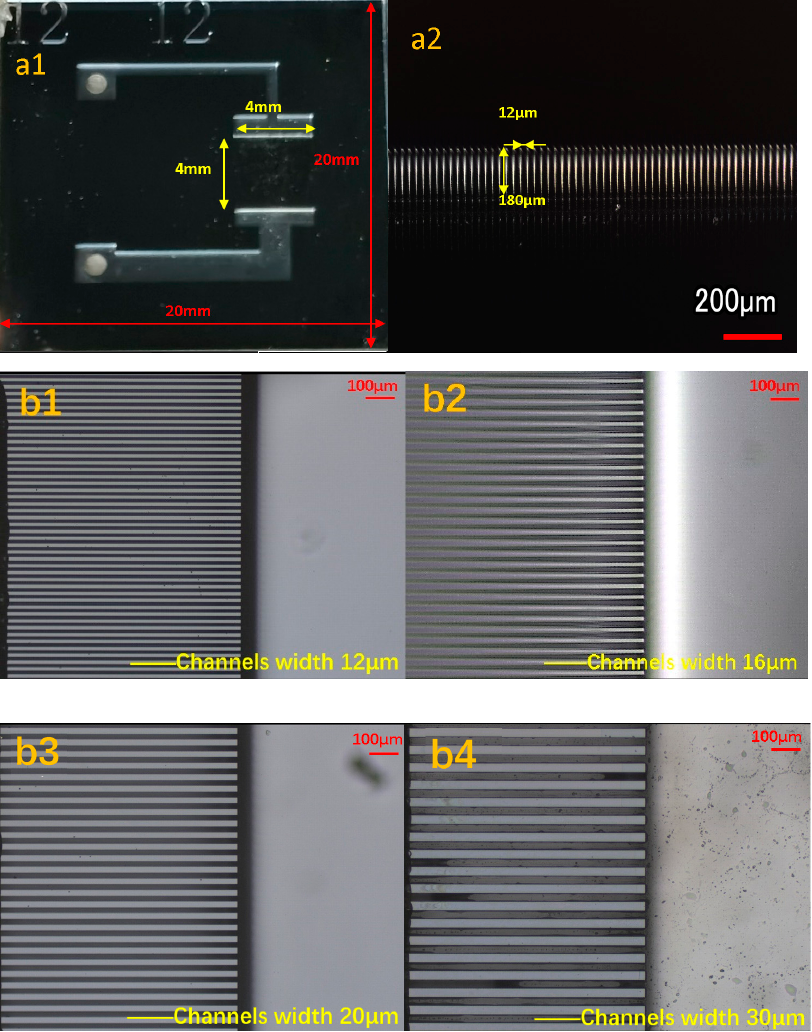
Figure 9. Microchannel sample images: ( a1 ) Overall structure of microchannel heat exchanger; ( a2 ) SEM image of the parallel microchannels array, in which each channel is 12 µ m wide and 180 µ m deep; ( b1 – b4 ) The images at the same magnification of the microchannel array, the depth of the parallel microchannel array is 180 μ m, the width are 12, 16, 20, 30 μ m.